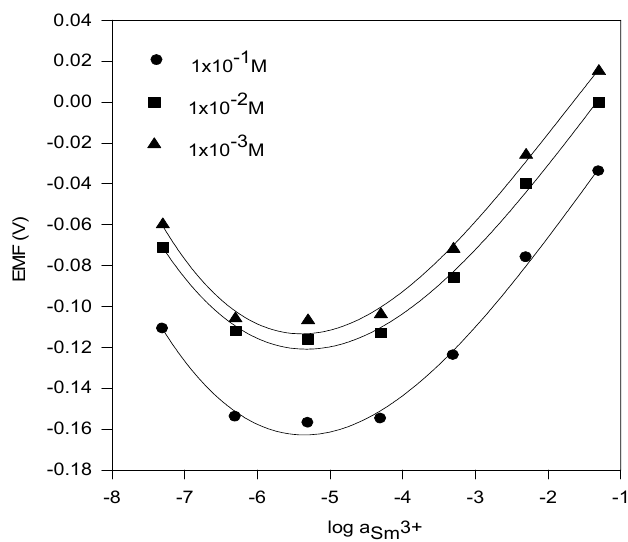
Figure 2. Effect of internal solution on potential response of the Sm (III) selective electrode based on SnBP.